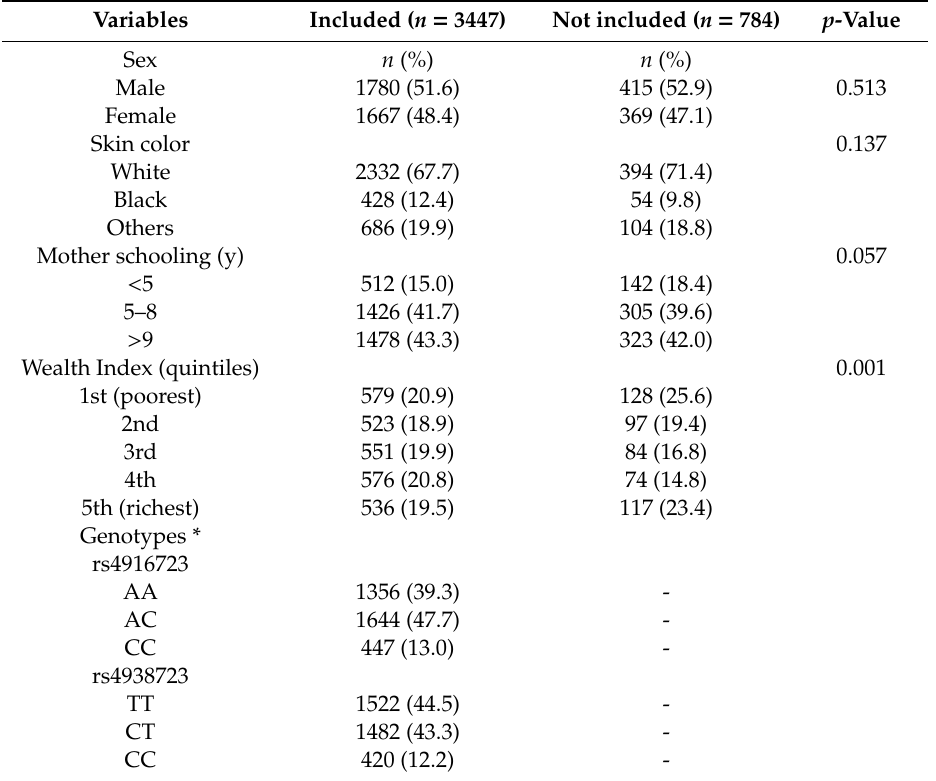
Table1. Sociodemographiccharacteristicsandgenotypefrequenciesdistributionamongtheparticipants of the 2004 Pelotas birth cohort.